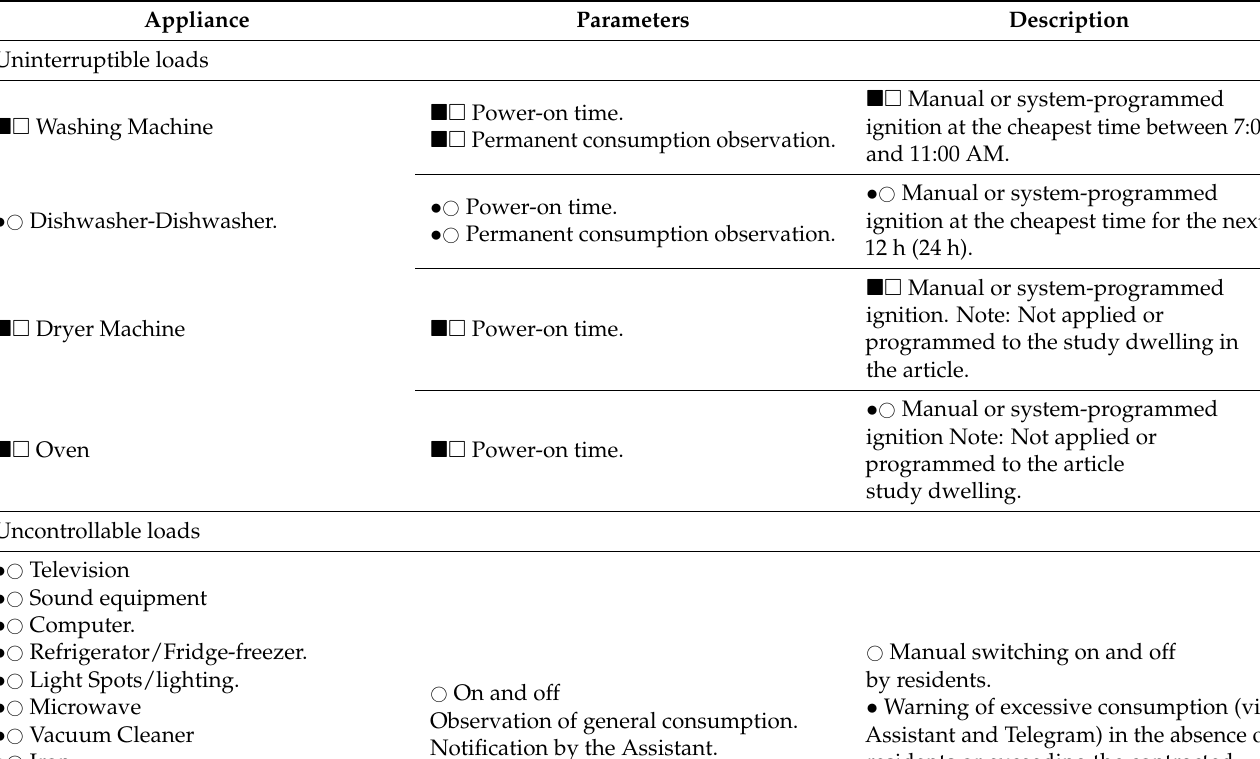
Table 2. Cont. Appliance Parameters Description Uninterruptible